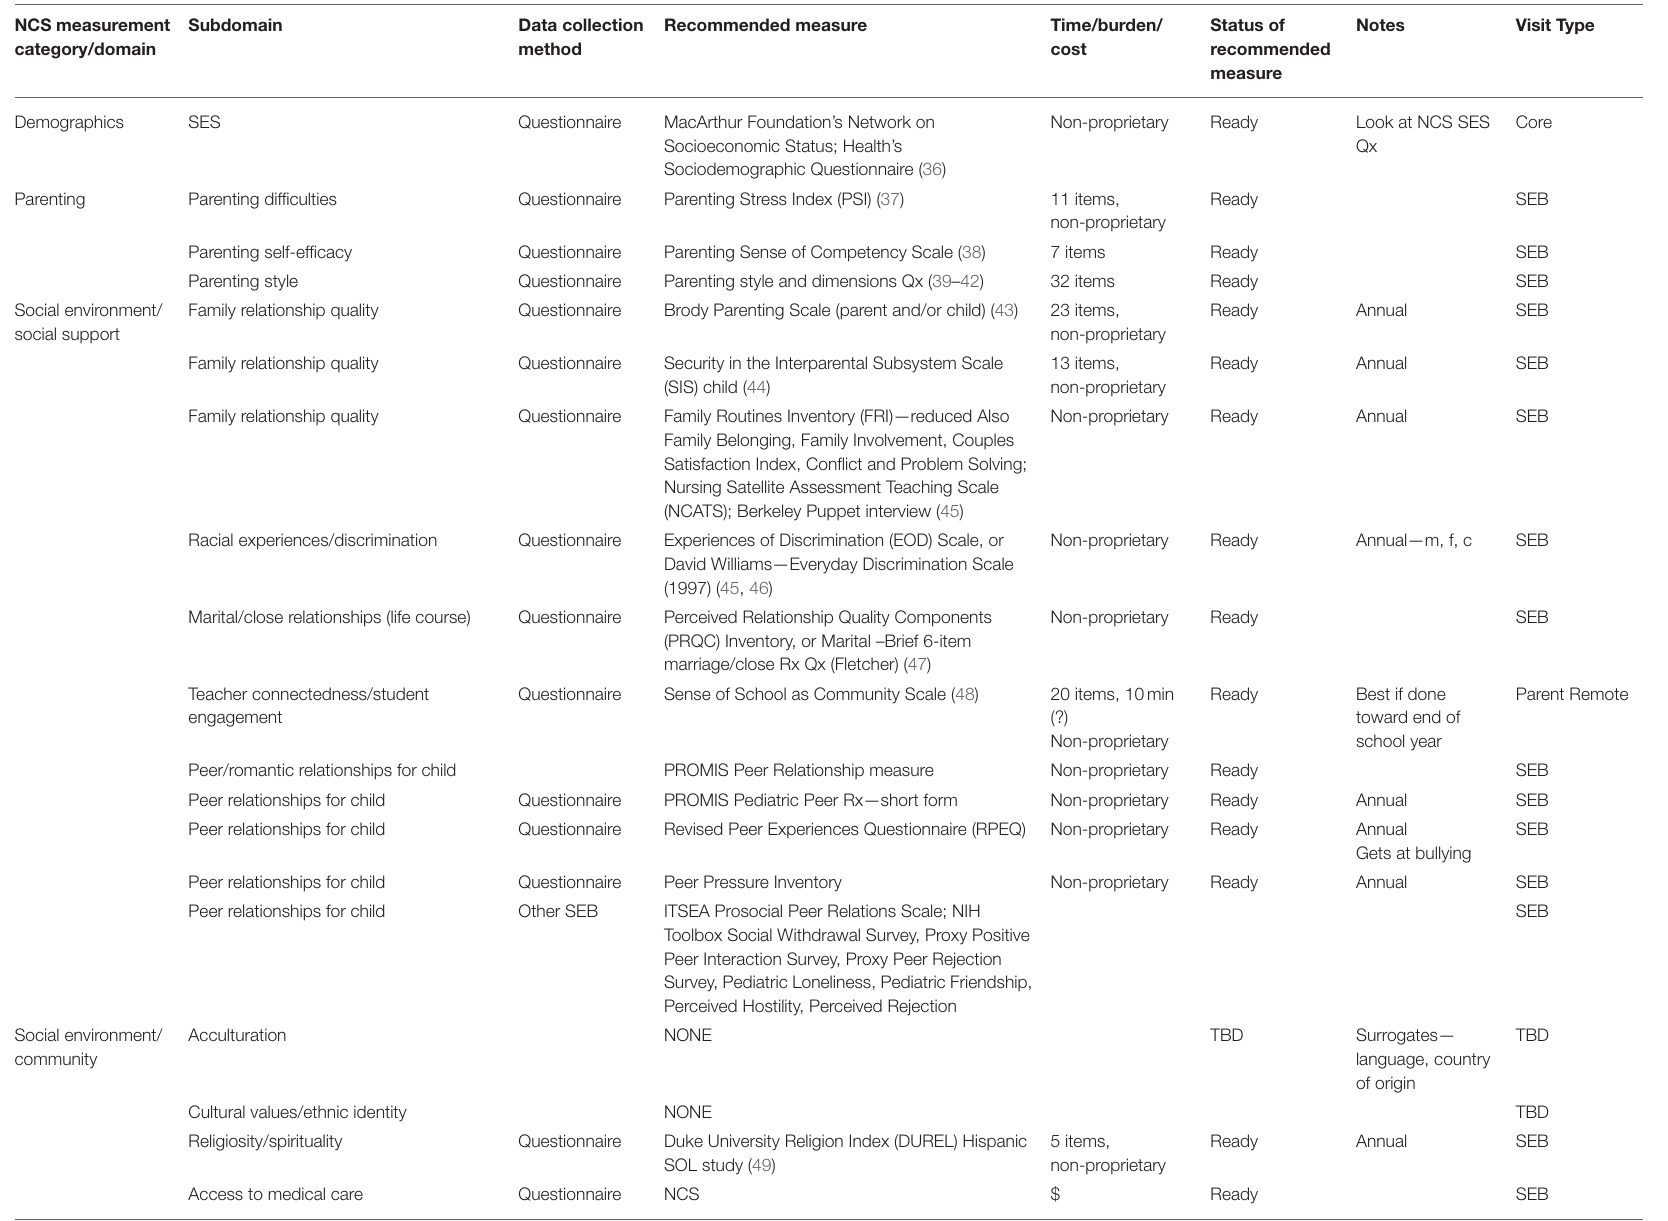
TABLE 4 | Domain: Social